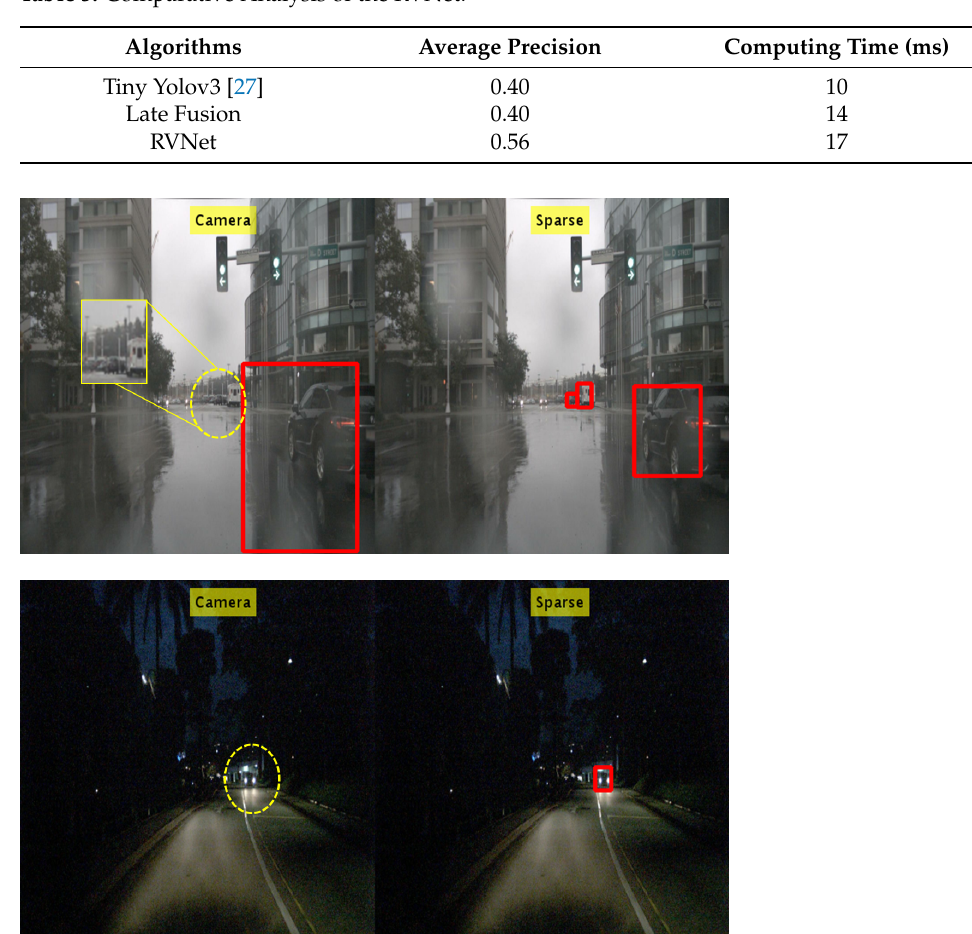
Figure 8. Detection result for the RVNet. The red bounding boxes and yellow circle indicate the true positives and false negatives,